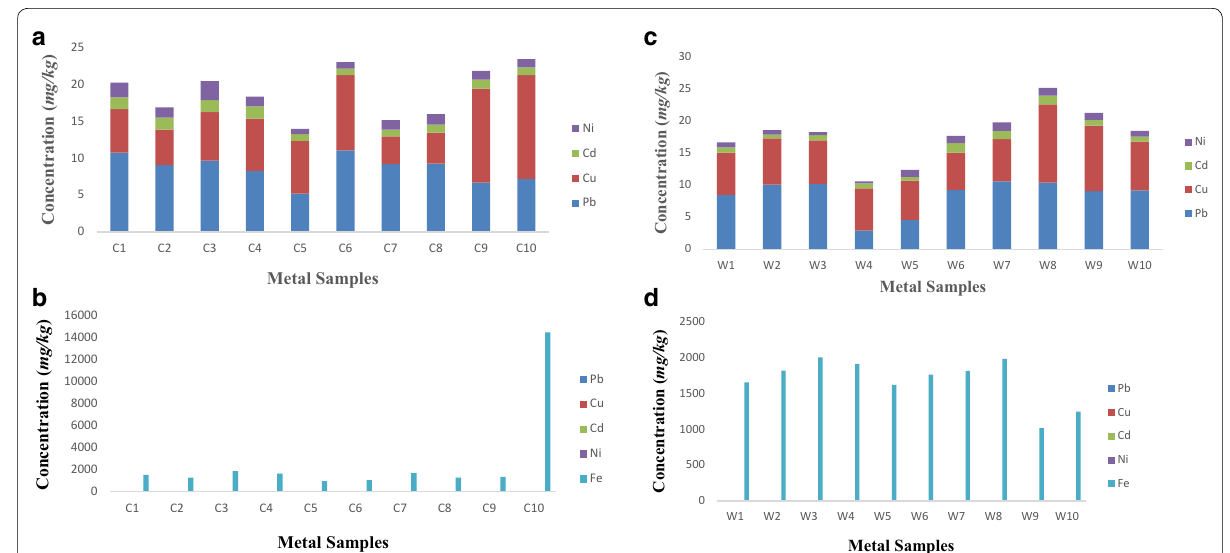
Fig. 2 a Bar chart of readings and spectrum for Ni, Cd, Cu and Pb in selected points in cold spring. b Bar chart of readings and spectrum for Fe in selected points in cold spring. c Bar chart of readings and spectrum for Ni, Cd, Cu and Pb in selected points in warm spring. d Bar chart of readings and spectrum for Fe in selected points in warm